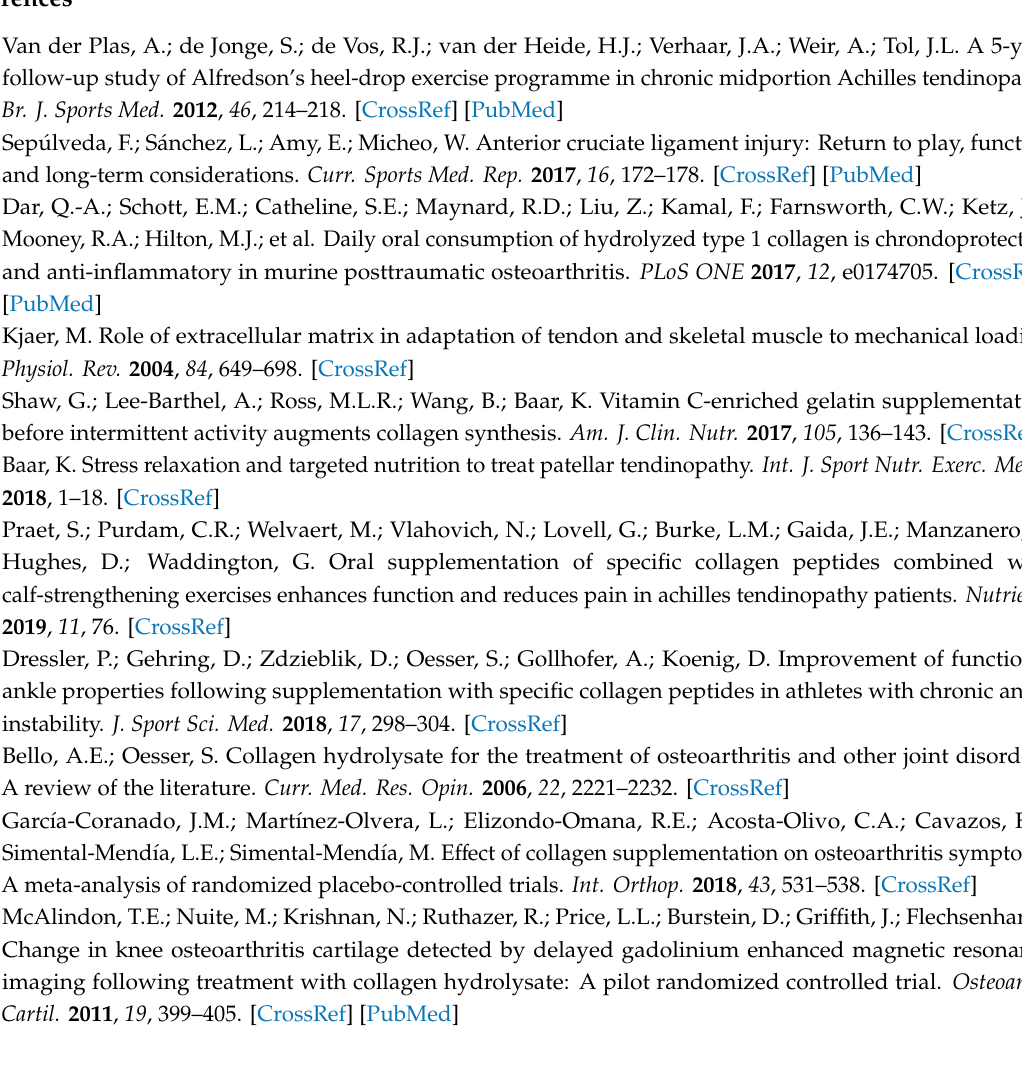
Table S1. Amino acid composition of the two collagen products included in the study, Figure S1: Plasma concentration of methionine for EHC, NC and placebo, Figure S2. Plasma concentrations of alanine, asparagine, glutamate, glutamine, histidine, serine, threonine and valine over time following ingestion of EHC, NC and placebo, Figure S3. Plasma concentrations of arginine, leucine, isoleucine, lysine, phenylalanine and total AAs over time following ingestion of EHC, NC and placebo, Figure S4. Plasma concentrations of EAA and BCAA over time following ingestion of EHC, NC and placebo, Figure S5. (A) Plasma concentrations of glucose over time for EHC, NC and placebo. (B) AUC is evaluated as incremental AUC from time − 20 min (Pre) to 240 min, Figure S6. E ff ects of EHC, NC and placebo on feelings of hunger over